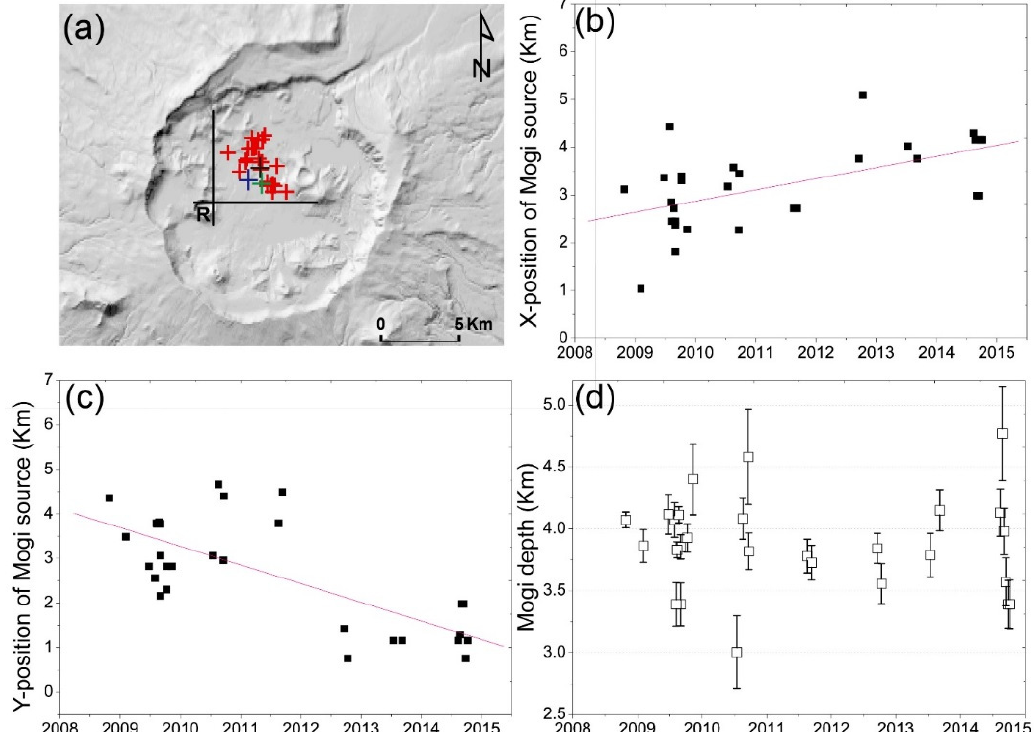
Figure 8. ( a ) Best-fit Mogi source horizontal locations (X is easting and Y is northing) for time-series deformation results from 2008 to 2014, superimposed on a shaded relief DEM image of Okmok volcano. Black cross represents the average position of the Mogi sources, green cross shows the average position of the deformation sources acquired from 1997 to 2008, and blue cross is the average position of the deformation sources from the 2008 eruption interferograms. ( b ) X position of the best-fit Mogi source as a function of time from 2008 to 2014, plotted relative to an arbitrary reference point R that is shown in Figure 8a. ( c ) Y position of the best-fit Mogi source as a function of time, plotted relative to an arbitrary reference point R that is shown in Figure 8a. East and north are taken as positive in both plots; ( d ) Depth of the best-fit Mogi source as a function of time from 2008 to 2014.The average source depth is about 3.9 km below sea level.